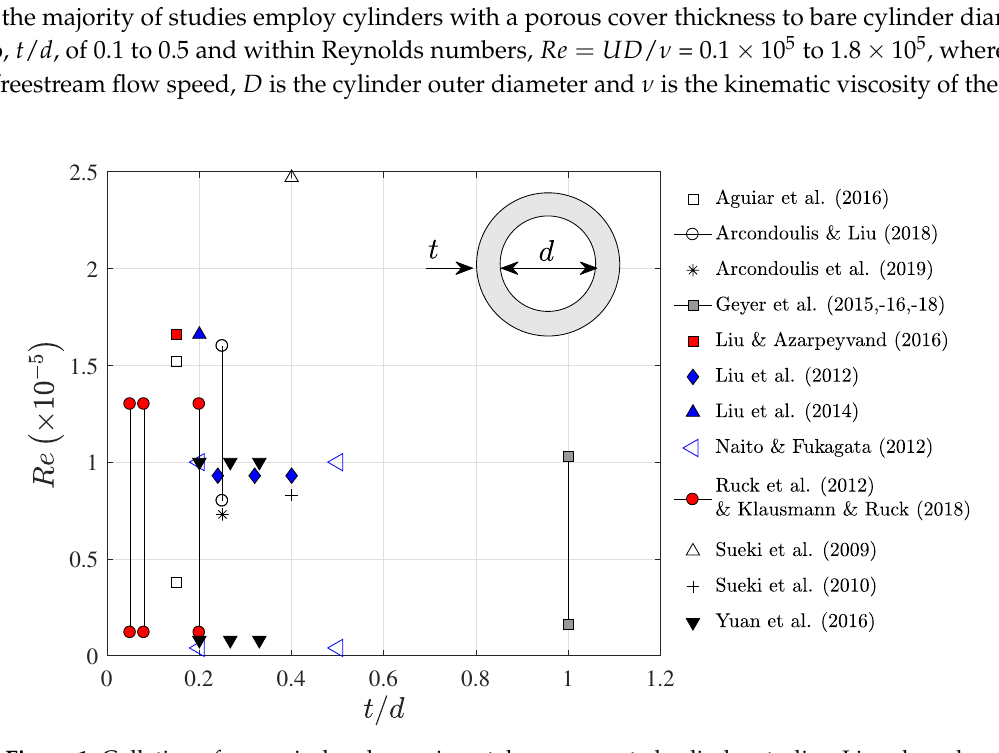
Figure 1. Collation of numerical and experimental porous coated cylinder studies. Lines have been drawn between points where experiments have been conducted at many Reynolds numbers for a specific cylinder configuration. The quantities t and d are labeled on a schematic diagram of a porous coated